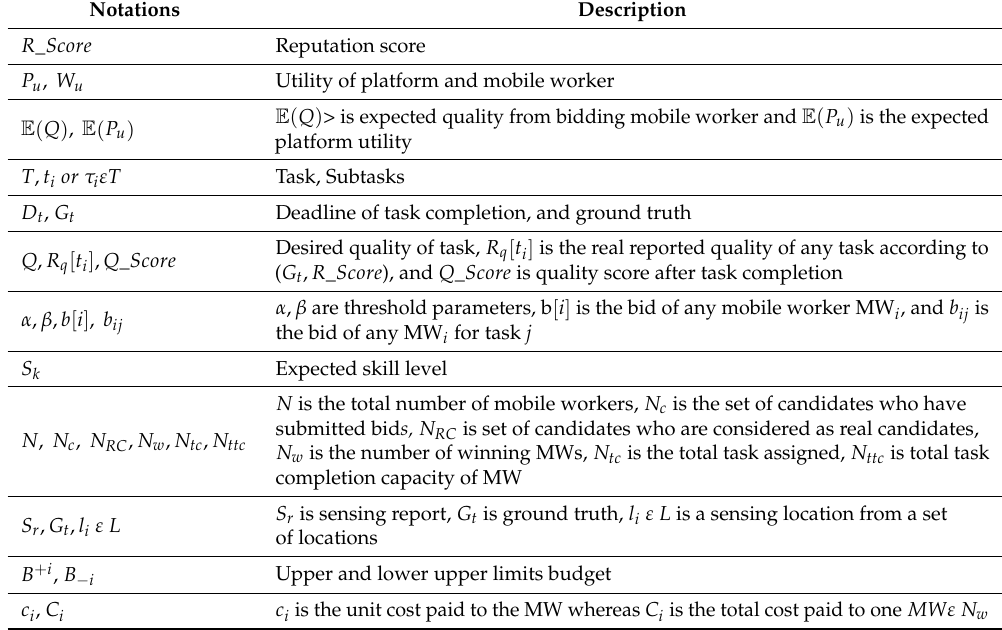
Table 1. Most frequently used notations in this